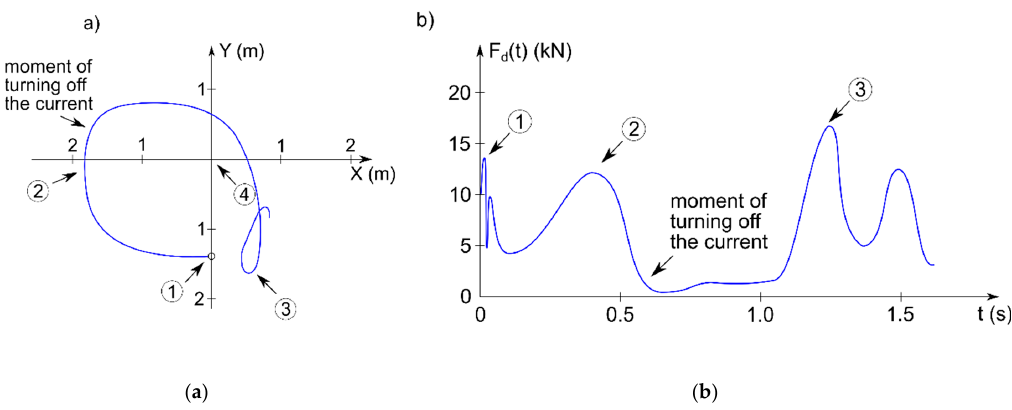
Figure 1. Movement of suspended wires between support structures: ( a ) Phase conductor motion due to phase current flow; ( b ) time of occurrence of characteristic dynamic forces acting at conductor suspension points; 1—sticking of conductors in the harness, 2—interphase interaction, 3—conductors’ droop, 4—suspension of conductors (Adapted from